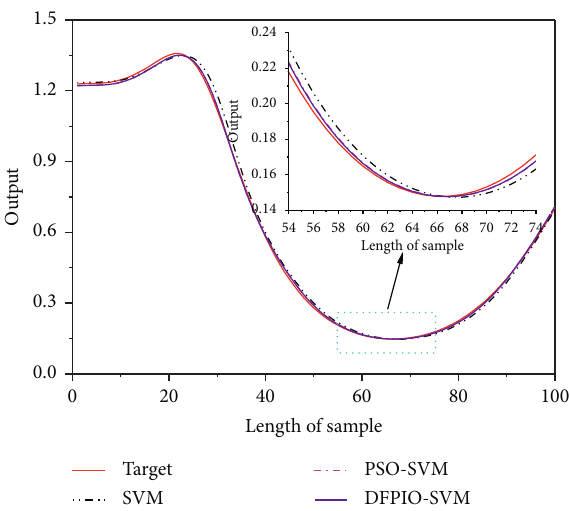
Figure 4: The target and prediction output for the Mackey–Glass time series.